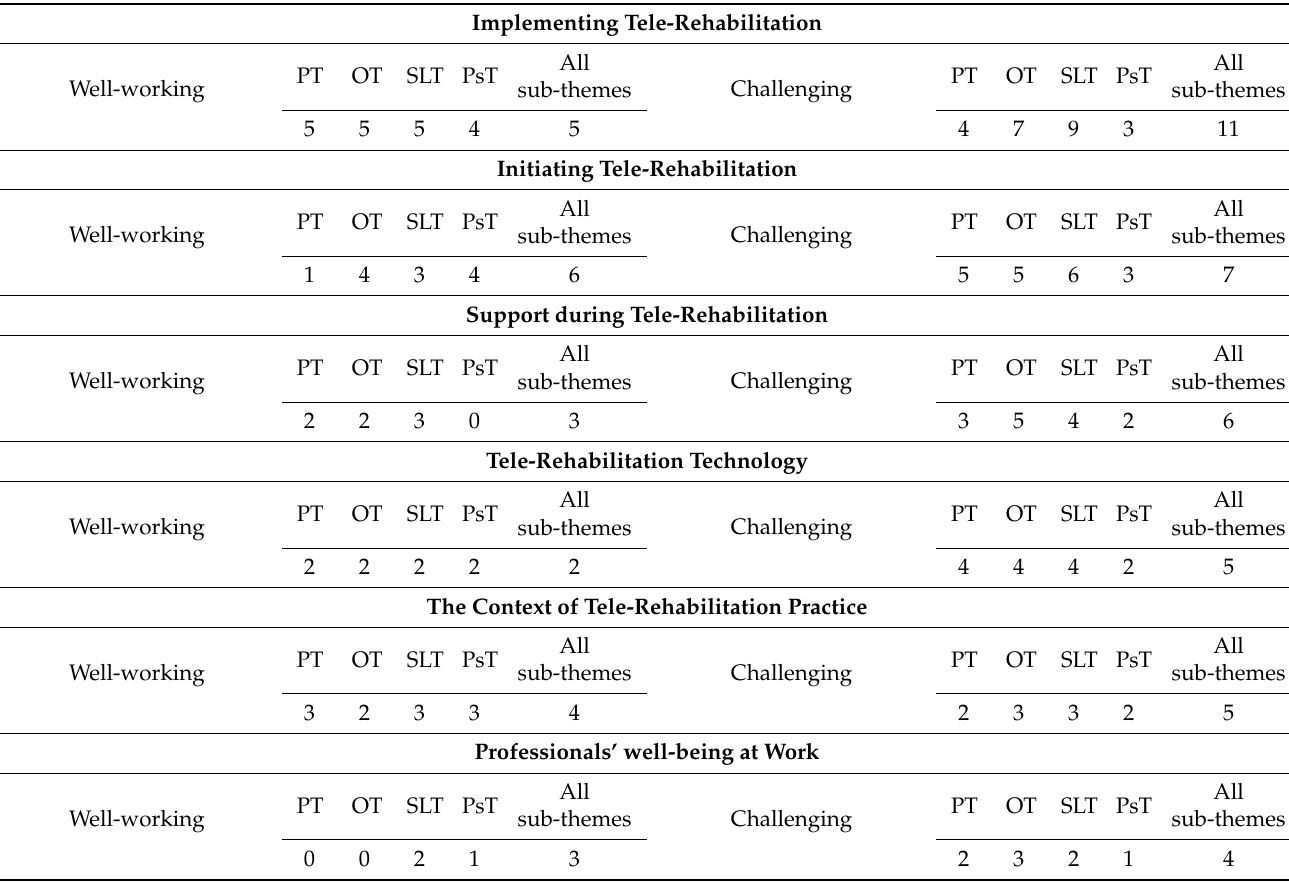
Table 6. The number of well-working and challenging sub-themes by professional group. Implementing